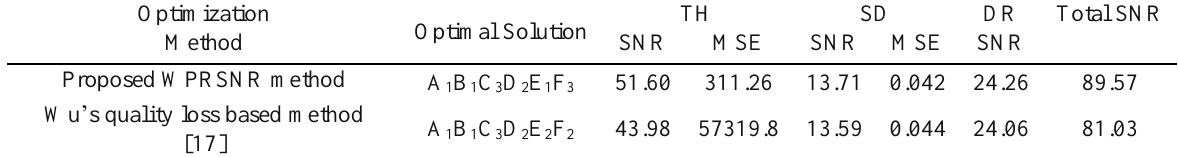
Table 4. Expected MSE and total SNR values under the optimal solutions obtained by the